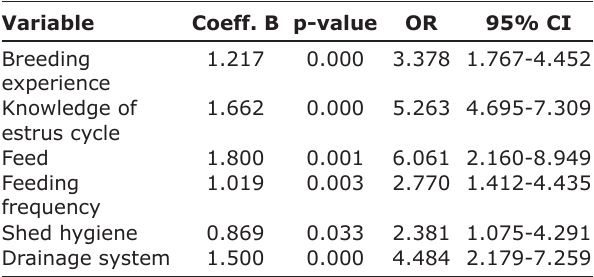
Table-5: Bivariate analysis between the frequency of repeat breeding and the risk factors of repeat breeding in beef cattle in Sleman Regency, Indonesia.